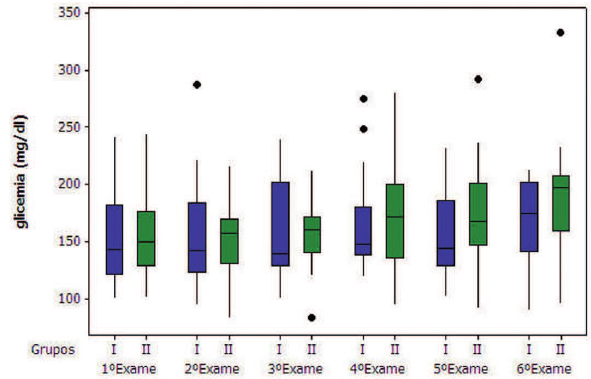
Fig. 2 - Box plot contendo os resultados dos exames seriados